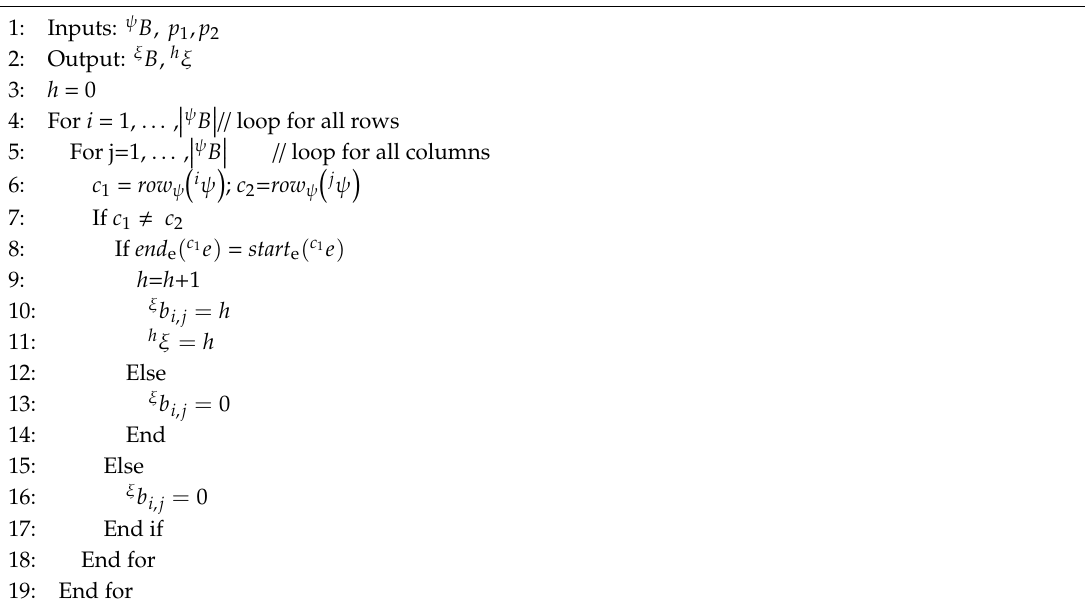
Algorithm 2 Determining the index of ξ